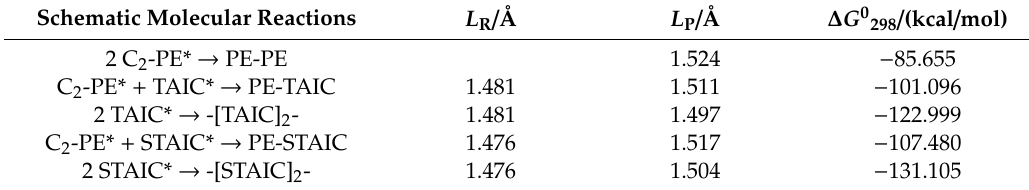
Table 4. The bond length L R of the reactant C–C bonds on the radical auxiliary crosslinking agent, the bond length L P of the produced C–C bonds connecting the crosslinked PE molecule or homopolymerized auxiliary crosslinking agent, Gibbs free energy ∆ G 0 298 in crosslinking and homopolymerization